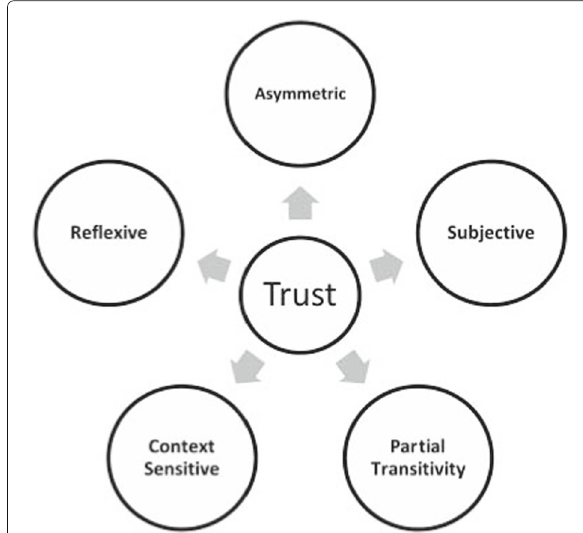
Among the trust schemes, statistics-based models such as Bayesian theory models [17–24] have received wide attention, based on which many trust models have been proposed by researchers in the past several years. The basis of trust mechanism is that its calculation is either